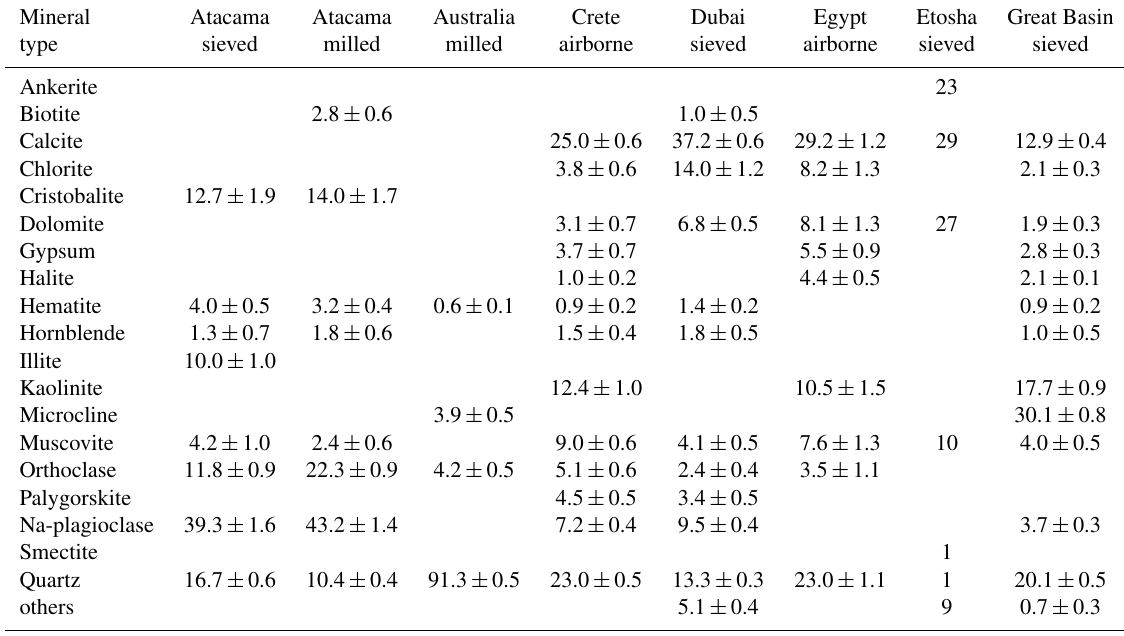
Table 2. Mineralogical composition in wt% and uncertainty from the Rietveld refinement (see text for details). Where microcline and orthoclase are present in the same sample, their individual fraction could not be distinguished reliably. Nevertheless, the best Rietveld fit results are given for orthoclase and microcline individually in these cases. The Etosha sample was taken from Kaufmann et al. (2016), who do not provide a Rietveld fit uncertainty from AutoQuan but estimate a 15% accuracy.